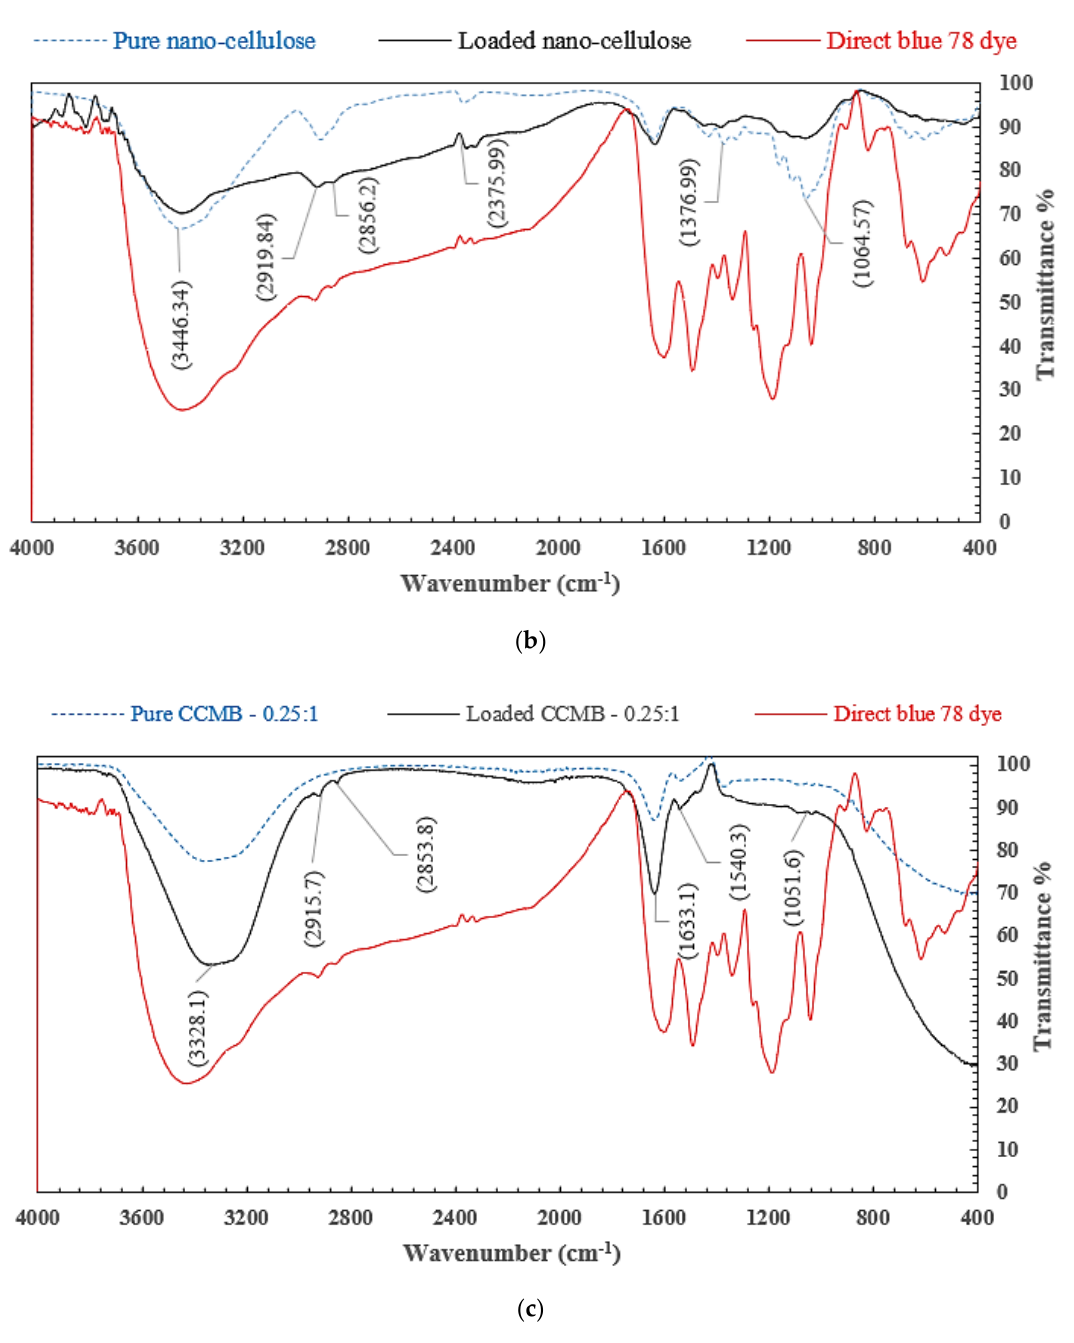
Figure 9. FTIR spectra for ( a ) pure and loaded chitosan, ( b ) pure and loaded nanocellulose, and ( c ) BD78 dye and CCMB-0.25:1 before and after adsorption process. ( c ) BD78 dye and CCMB-0.25:1 before and after adsorption process. For chitosan, it was observed from batch adsorption tests that a removal percentage of 94% can be obtained by using a chitosan dose of 3 g/L for a solution with an initial concentration of 50 mg/L, as shown in Figure 10. The maximum equilibrium loading reached was 74.4